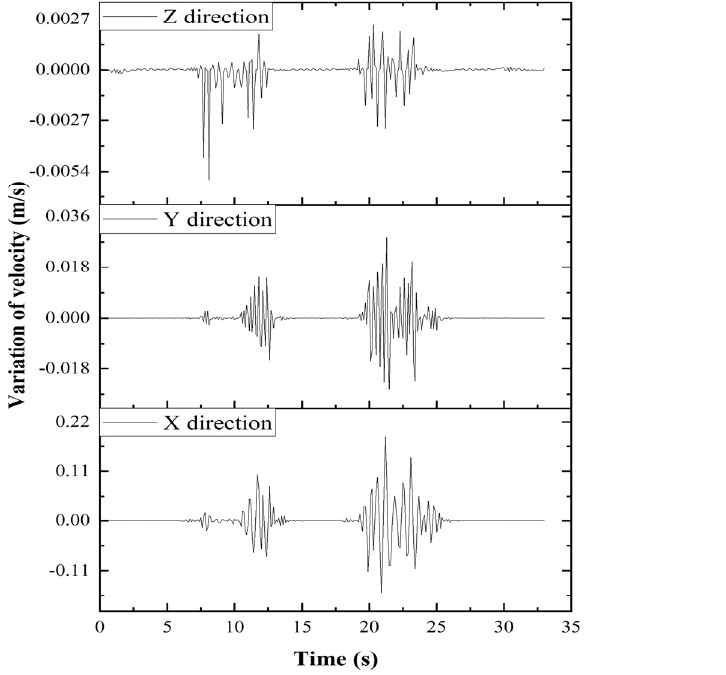
Figure 18. Velocity variation of bee frame in each direction under upland sandy loam conditions during s-curve driving.